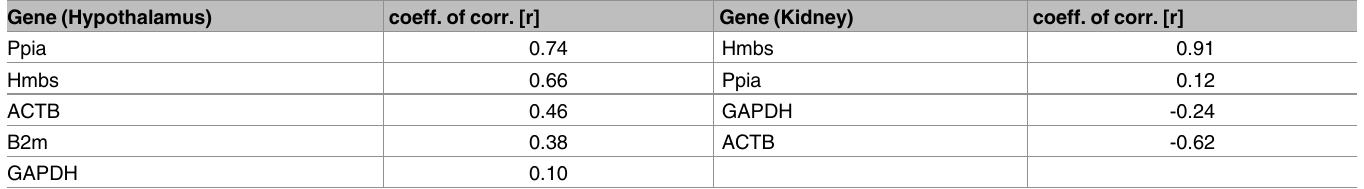
Table 3. Suitable reference genes for both hypothalamus and kidney. Shows the suitablereference genesfor both hypothalamus and kidney were Ppia& Hmbs. Gene (Hypothalamus) coeff. of corr. [r] Gene (Kidney) coeff. of corr. [r] Ppia 0.74 Hmbs 0.91 Hmbs 0.66 Ppia 0.12 ACTB 0.46 GAPDH -0.24 B2m 0.38 ACTB -0.62 GAPDH